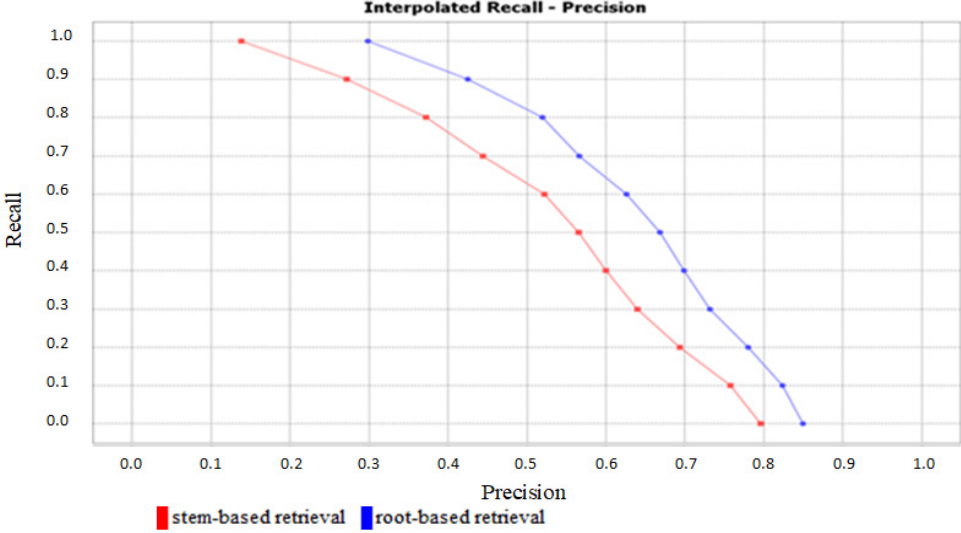
Figure 3. Recall-precision curves for the stem-based and root-based text representations.